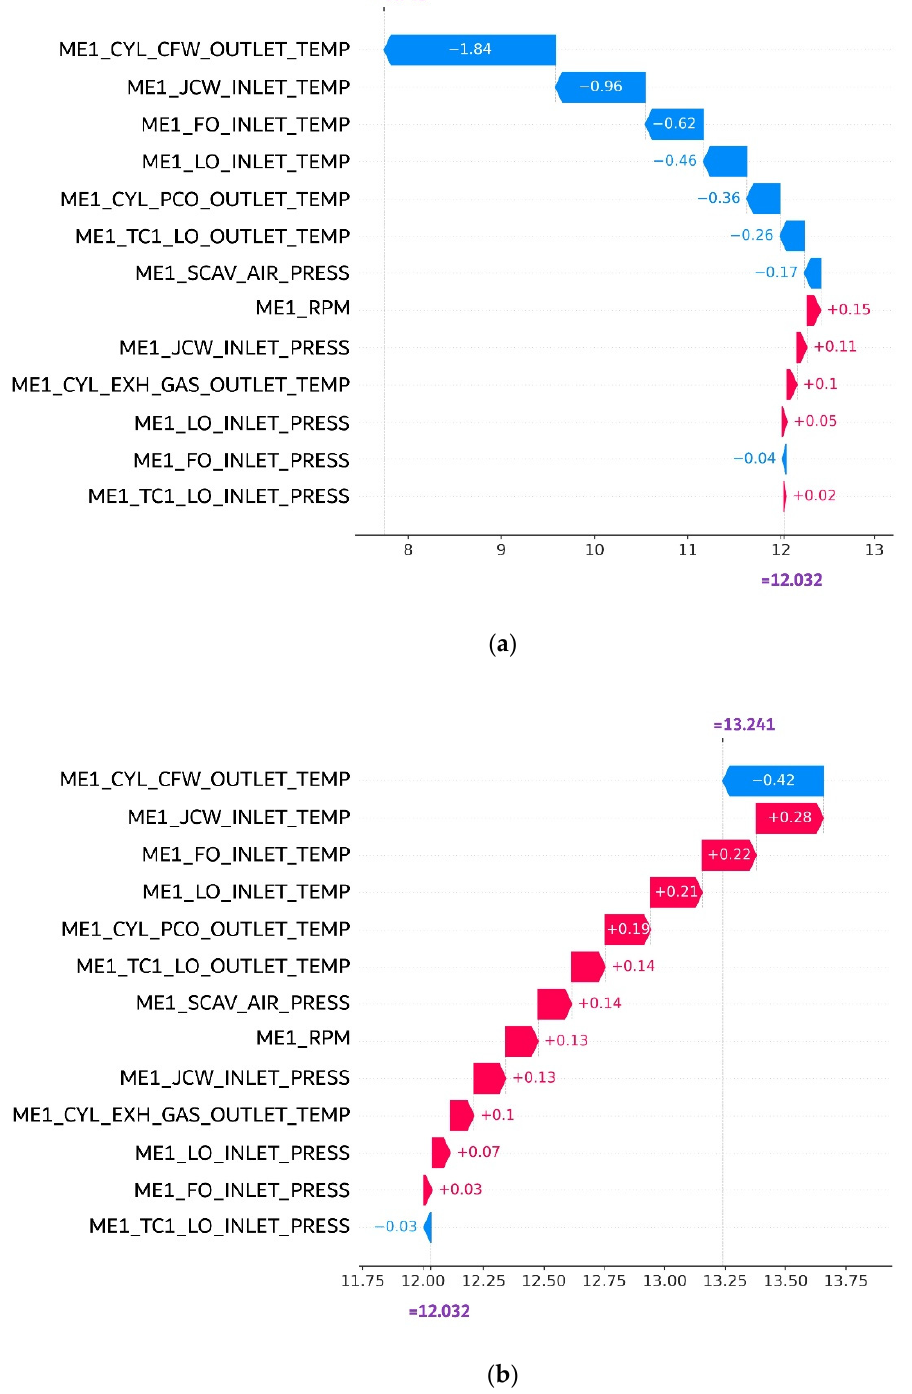
Figure 10. The comparison between SHAP values between two randomly sampled data instances: ( a ) anomaly instances; ( b ) normal instances.